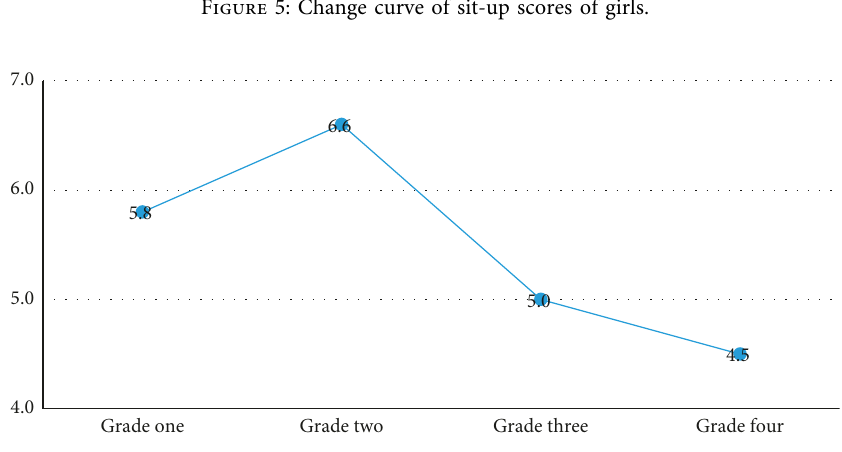
Figure 5: Change curve of sit-up scores of girls.